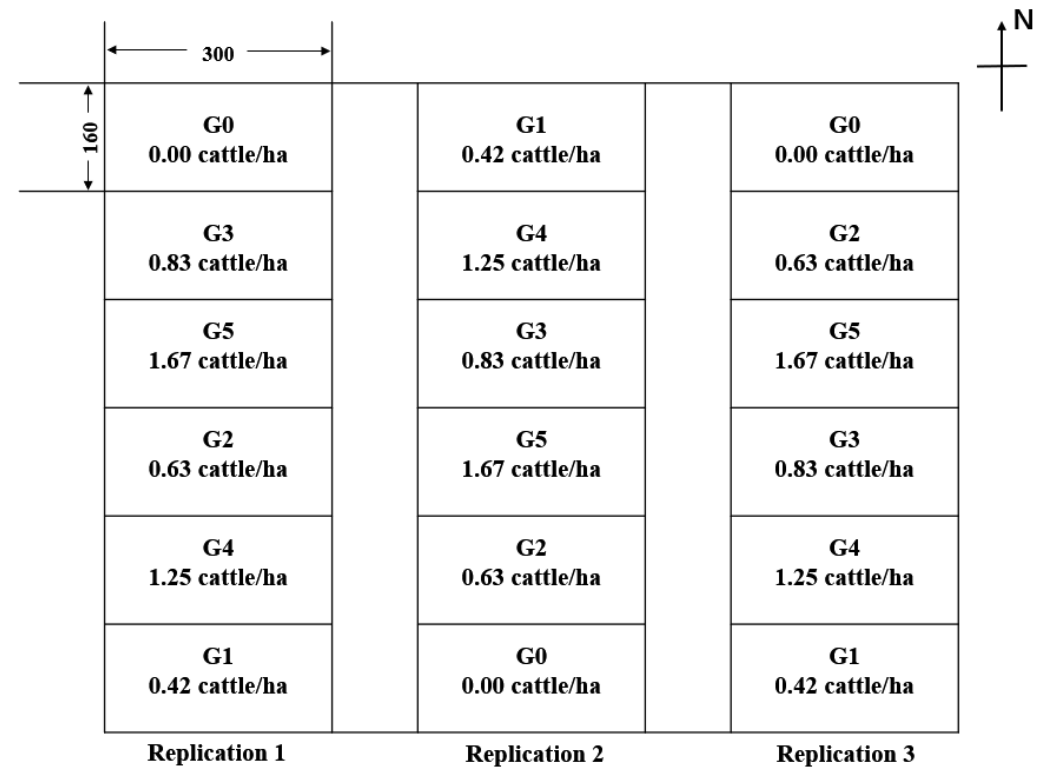
Figure A1. Sketch map of the experimental site.